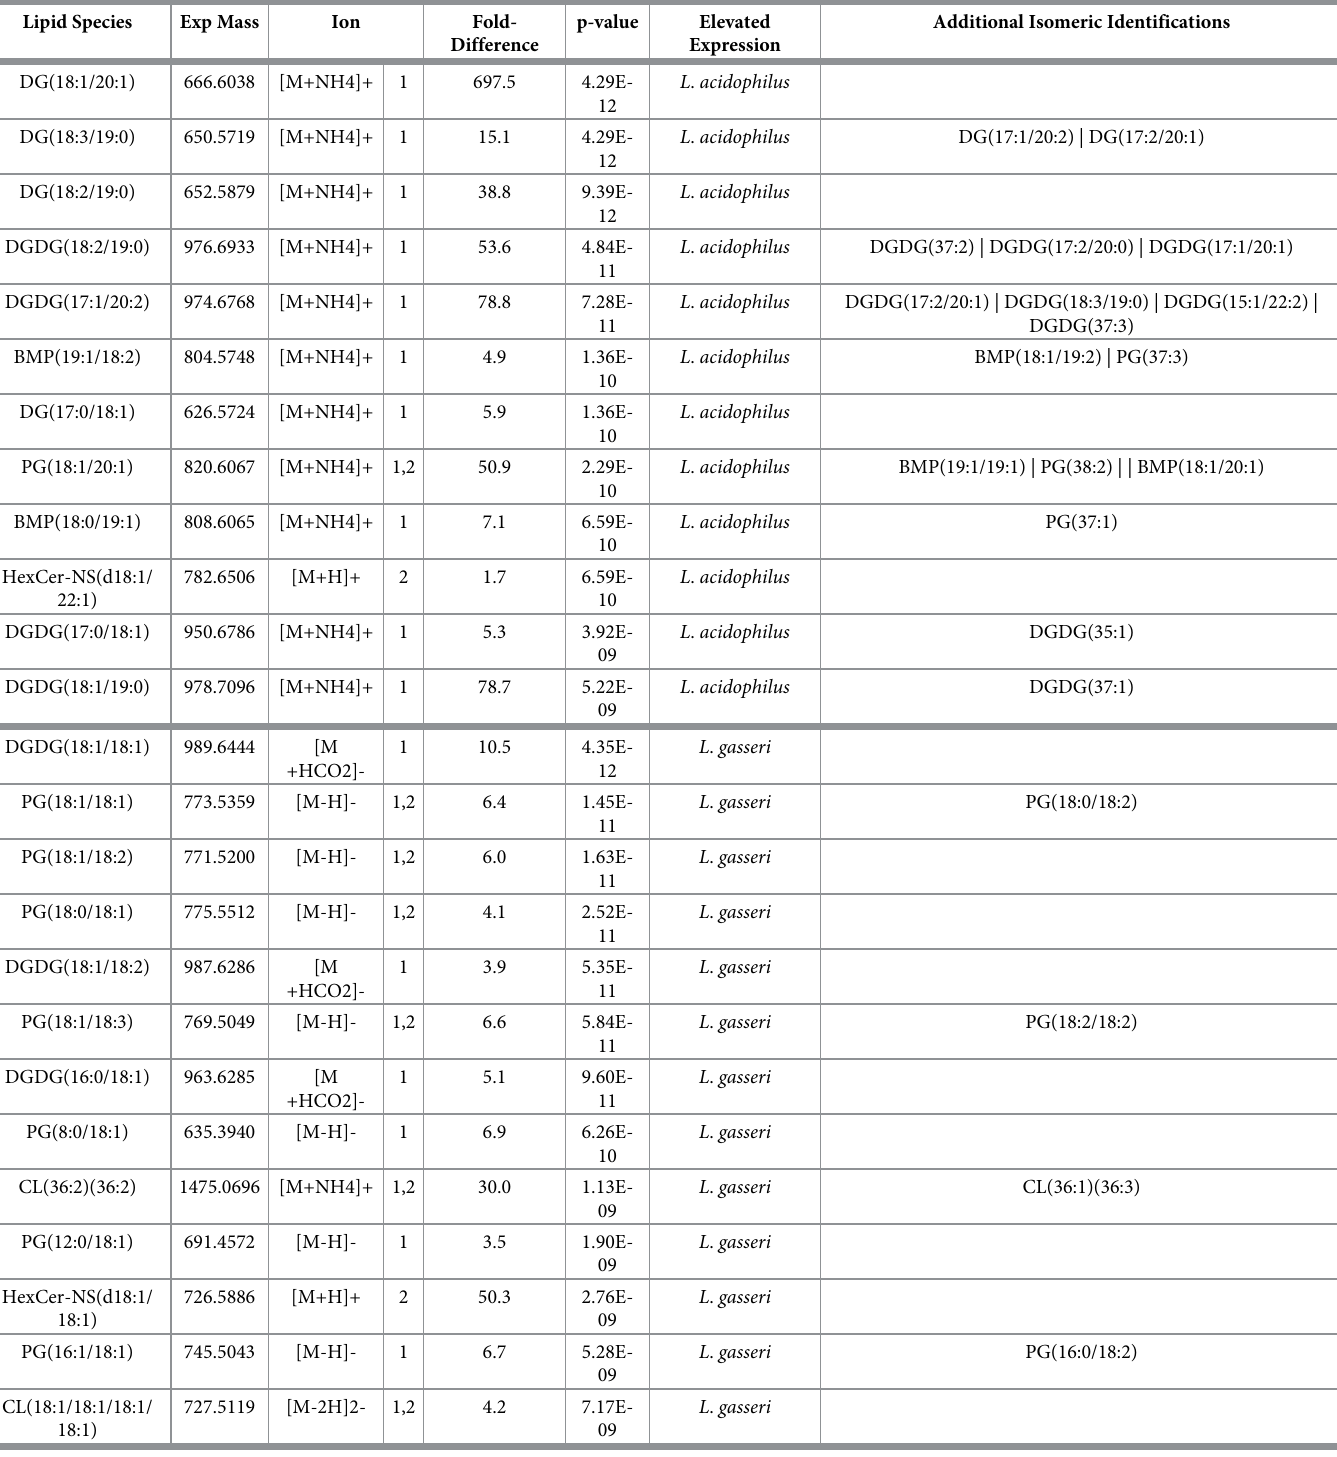
Table 2. Top-25 identified lipids of greatest significant difference in signal intensity between L . acidophilus and L . gasseri . Lipid Species Exp Mass Ion Fold-